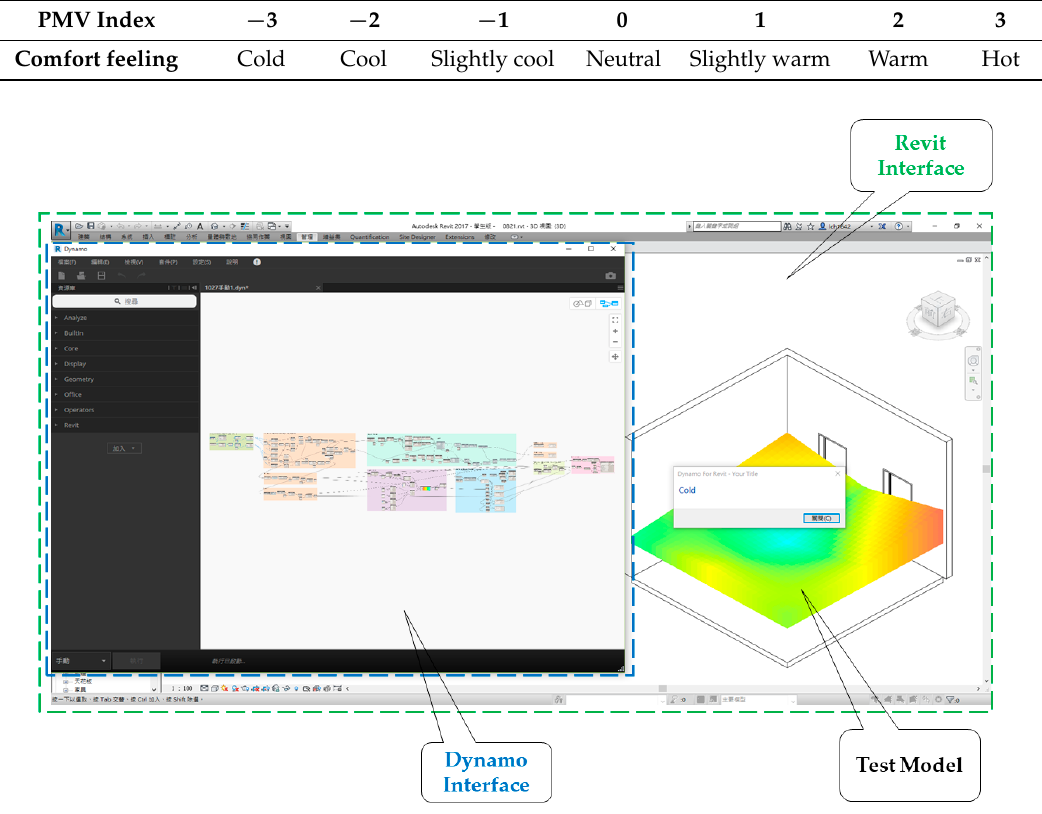
Figure 13. PMV analysis results in the BIM model.